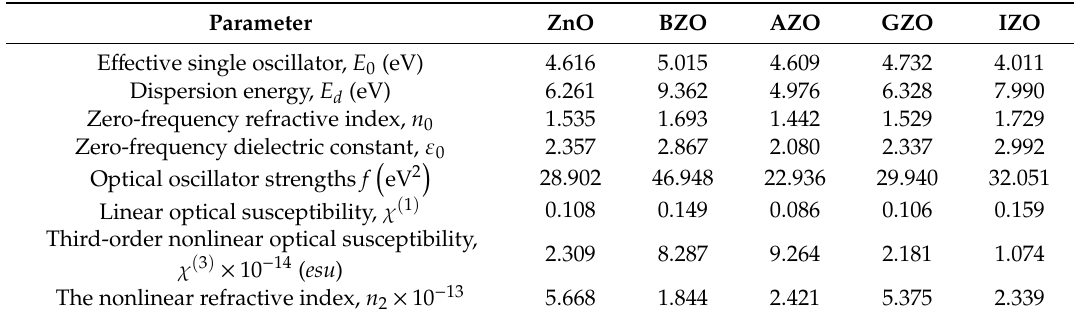
Table 2. Estimation of some essential optoelectronic parameters of undoped ZnO and group III elements (B, Al, Ga, and In)-doped ZnO thin films at 3% doping